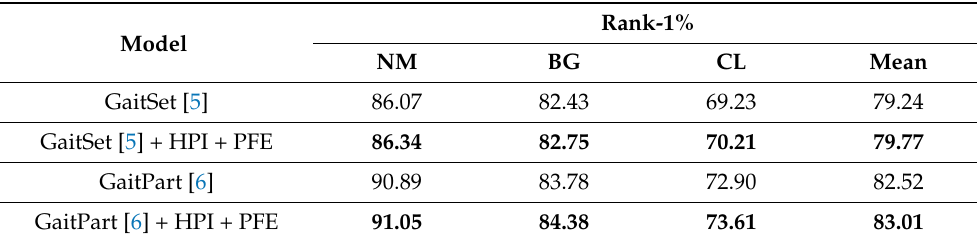
Table 7. Translating the HPI and PFE modules to other methods in the Multi-state Gait dataset. The bolds indicate the best accuracy in this